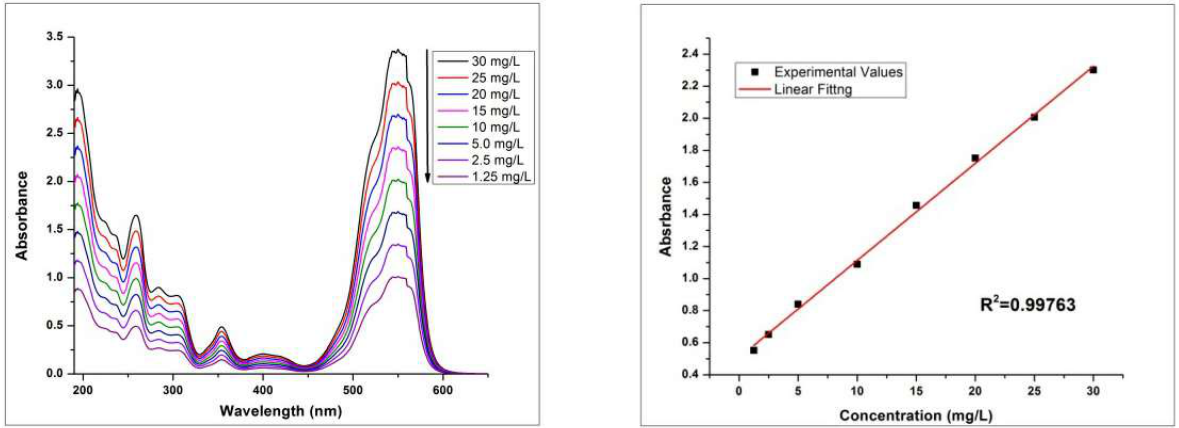
Figure 18. UV-Vis plot of standard aqueous solutions of RhB for different concentrations ( left ) and the linear fit standard curve ( right ).